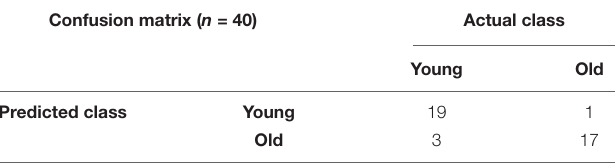
TABLE 2 | Confusion matrix constructed by classification model of random forest.